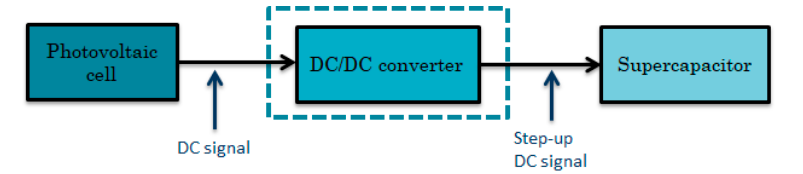
Figure 8. DC complete system block diagram.